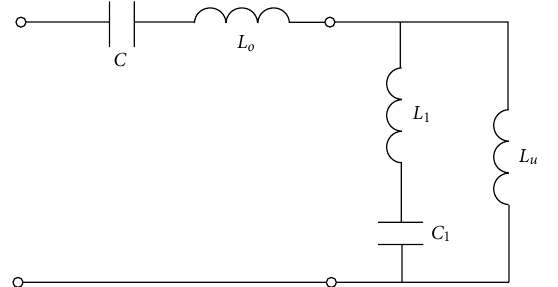
Figure 7: Resonant circuit for the computation of frequencies f 1,2 .